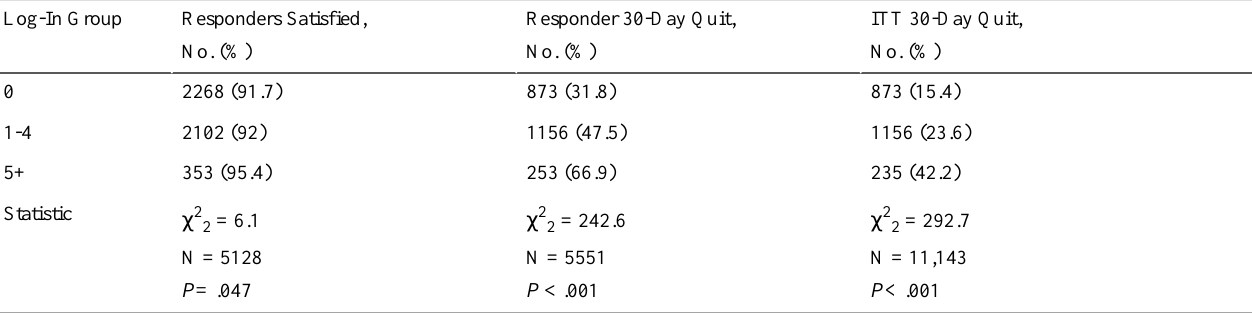
Table 4. Satisfaction and 30-day quit rates, by Web Coach log-in group